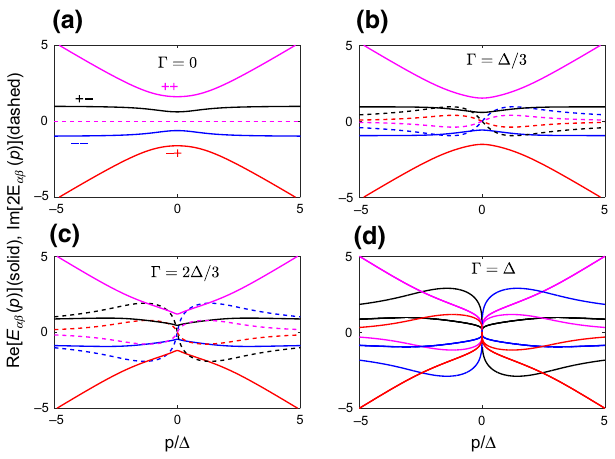
FIG. 6. The evolution of the instantaneous spectrum of H ( 4 ) . The real and imaginary parts as a function of (cid:5) are shown in solid and dashed curves, respectively. The evolution starts from the Hermitian case with (cid:5) = 0 (a), through the PT -broken regions (b) and (c), and ends at (cid:5) = (cid:3) (d), where the EP4 appears at p =